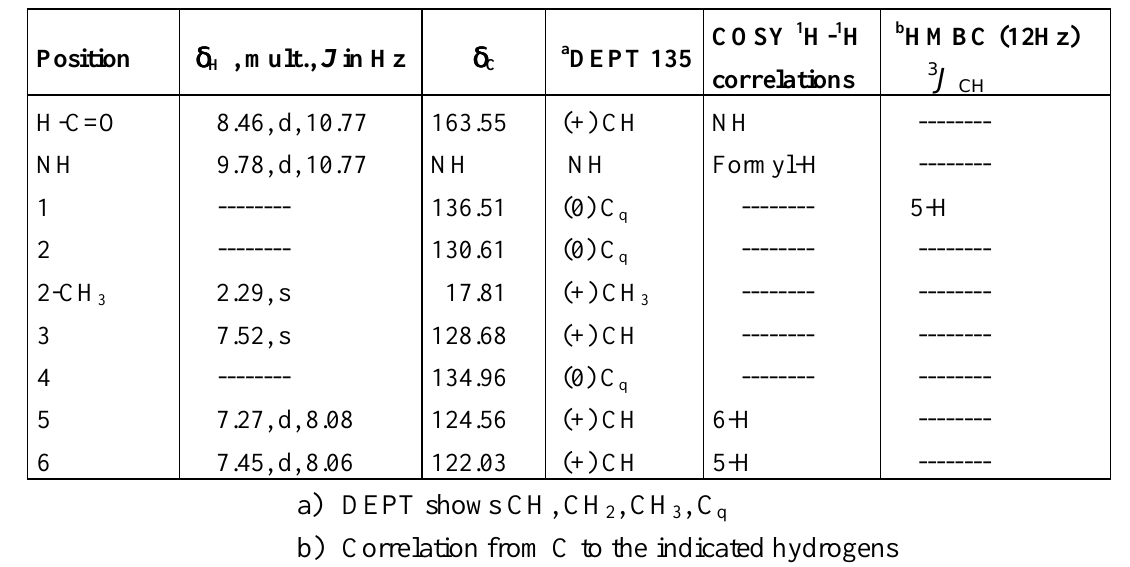
Table 4. 1 H(400 MHz) and 13 C NMR (100MHz) Spectral Data for 5 - trans in DMSO- d